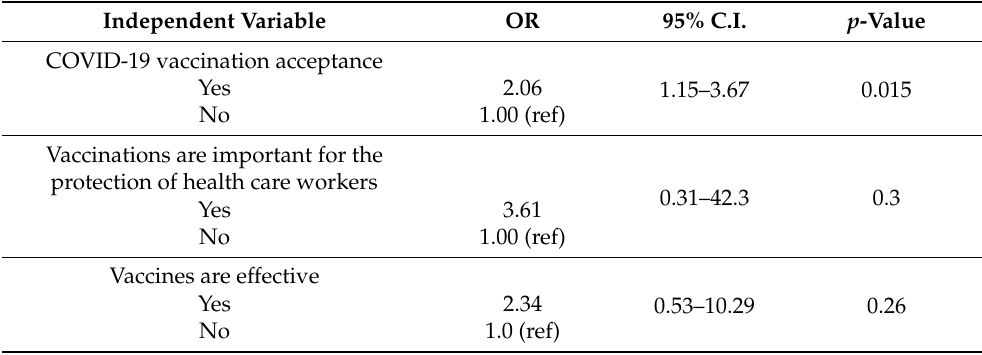
Table 2. Logistic regression analysis for influenza vaccination coverage